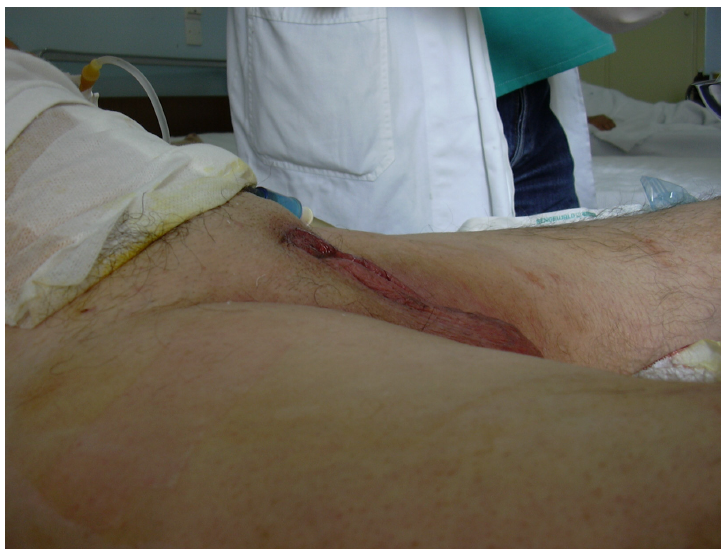
FIGURE 3 . Profile view of “vanished” penis.